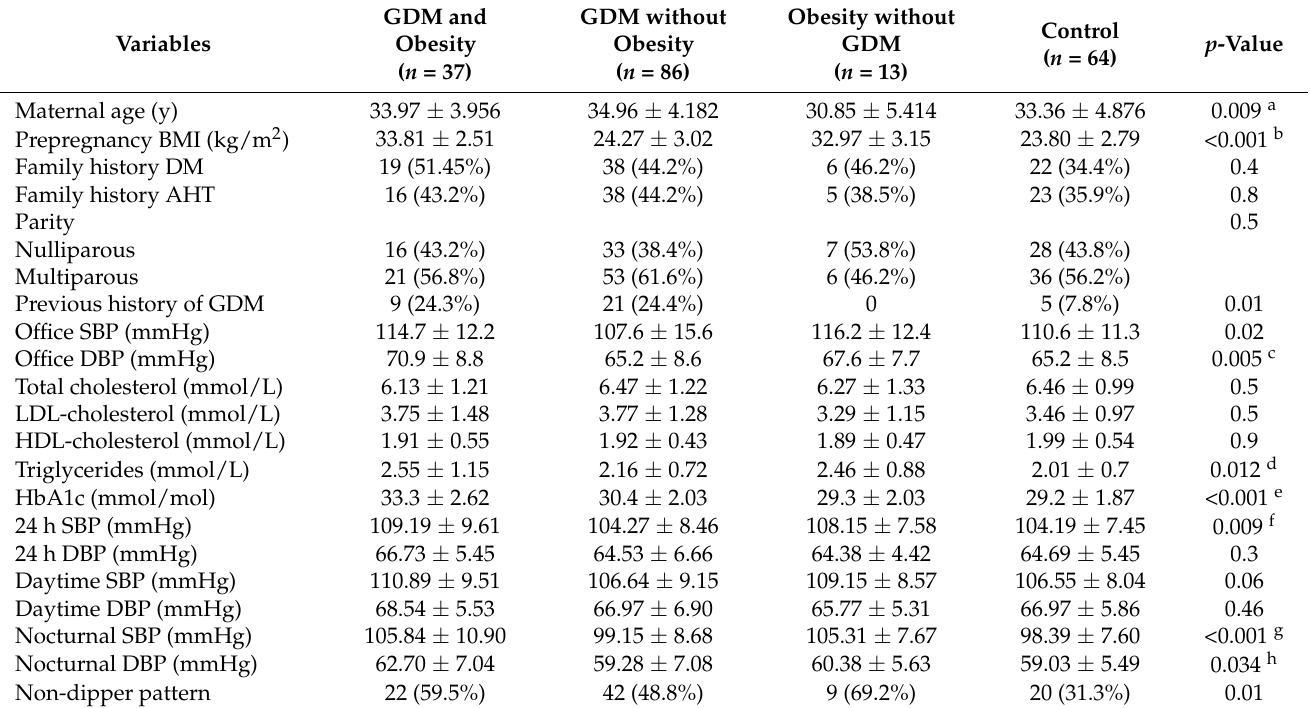
Table 1. Demographic, clinical, and laboratory variables, and ABPM parameters according to presence of GDM and/or